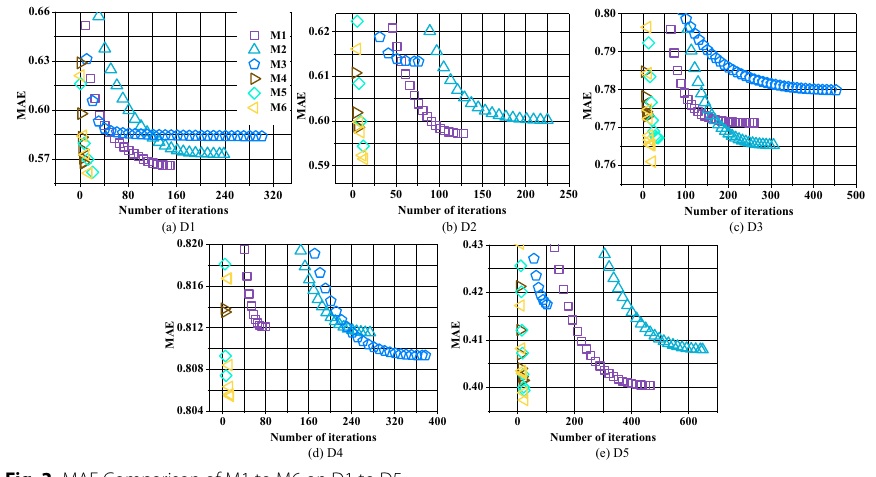
Fig. 3 MAE Comparison of M1 to M6 on D1 to